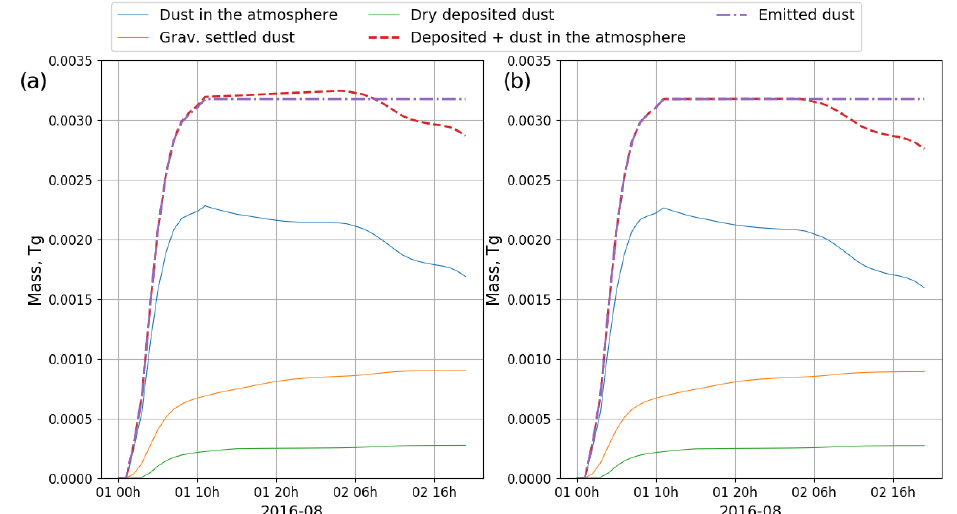
Figure 5. Dust mass balance check (a) before and (b) after correction of gravitational settling. Deposited dust is the combination of gravita- tionally settled dust and dry deposited